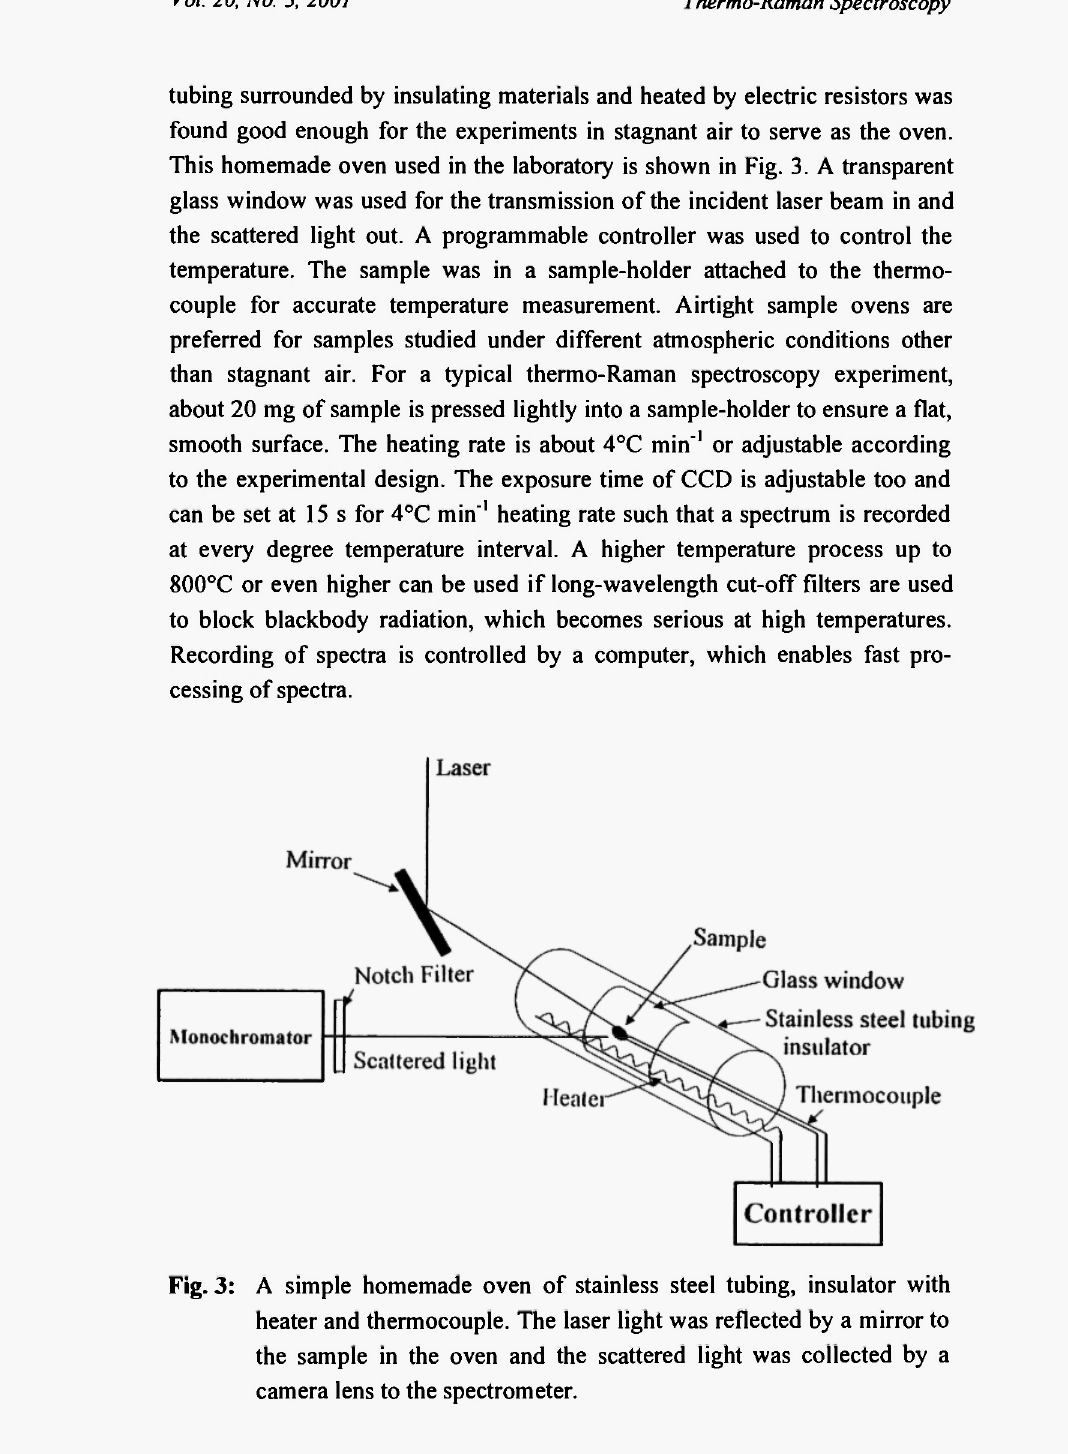
Fig. 3: A simple homemade oven of stainless steel tubing, insulator with heater and thermocouple. The laser light was reflected by a mirror to the sample in the oven and the scattered light was collected by a camera lens to the